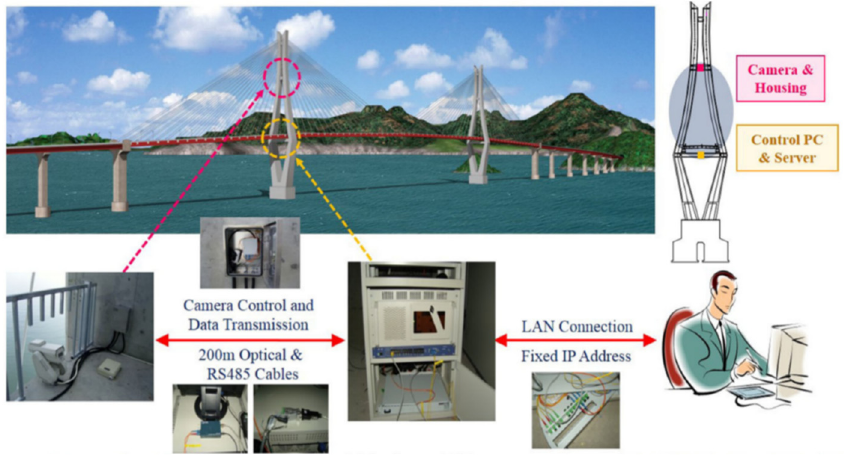
Figure 16. Vision-based monitoring system for cable stayed bridge [204].